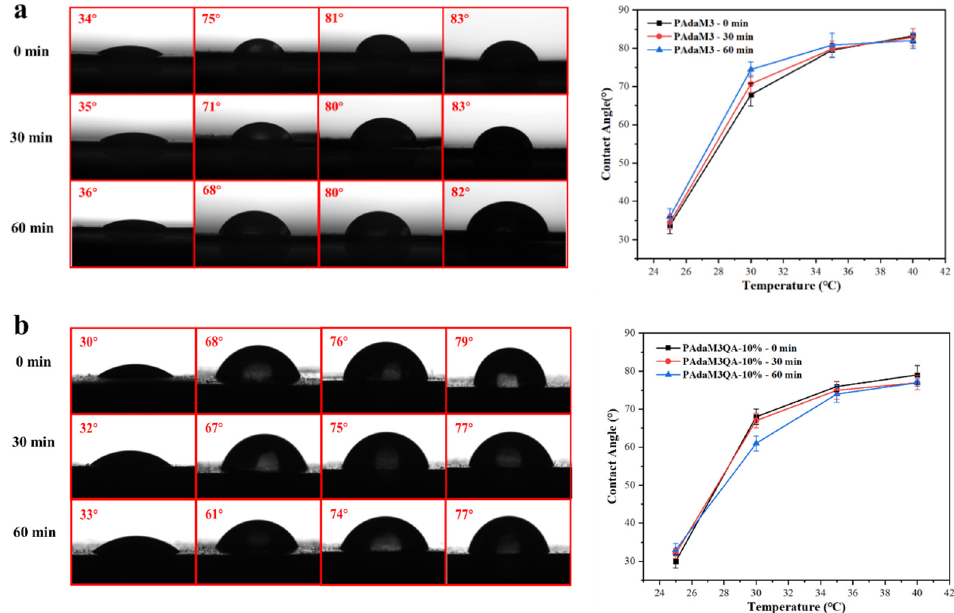
Figure 9. ( a ) The images and curves of WCA of PAdaM3 coating; ( b ) the images and curves of WCA of PAdaM3QA − 10% coating. of PAdaM3QA − 10%